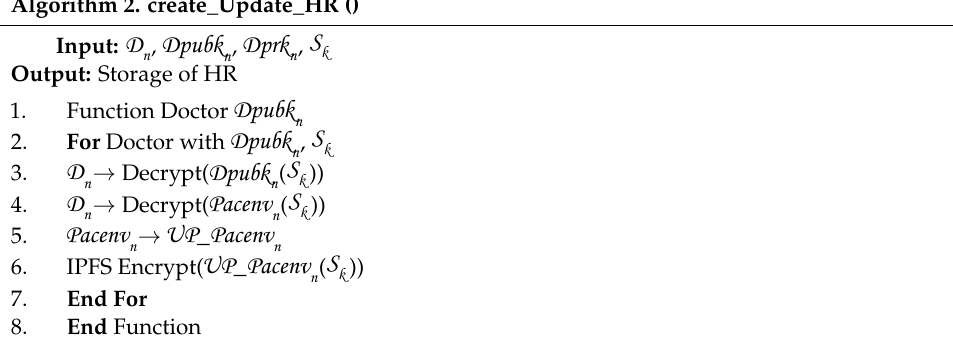
Table 5. Symbols in the algorithm functions.